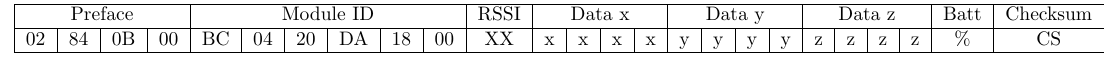
Figure 6. Bluetooth Low Energy (BLE) data packet structure: The data is composed of a preface, the module ID, three Euler angles, the remaining battery charge (percentage) and a checksum.